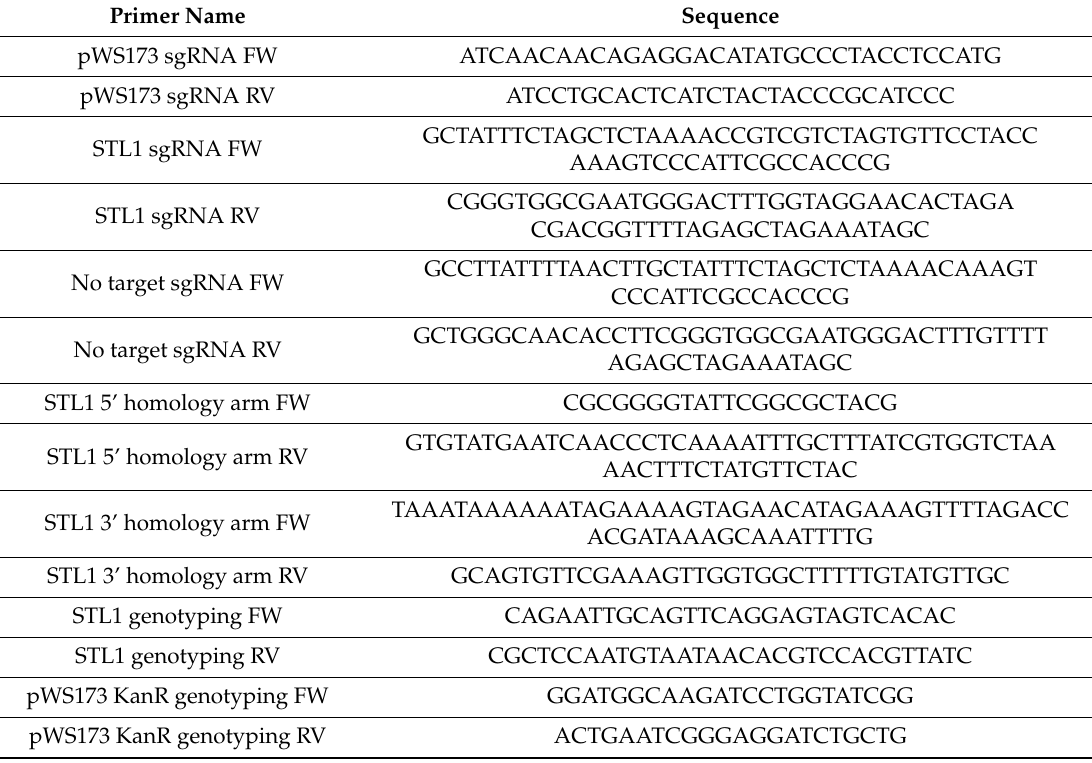
Table A2. Primers used in this